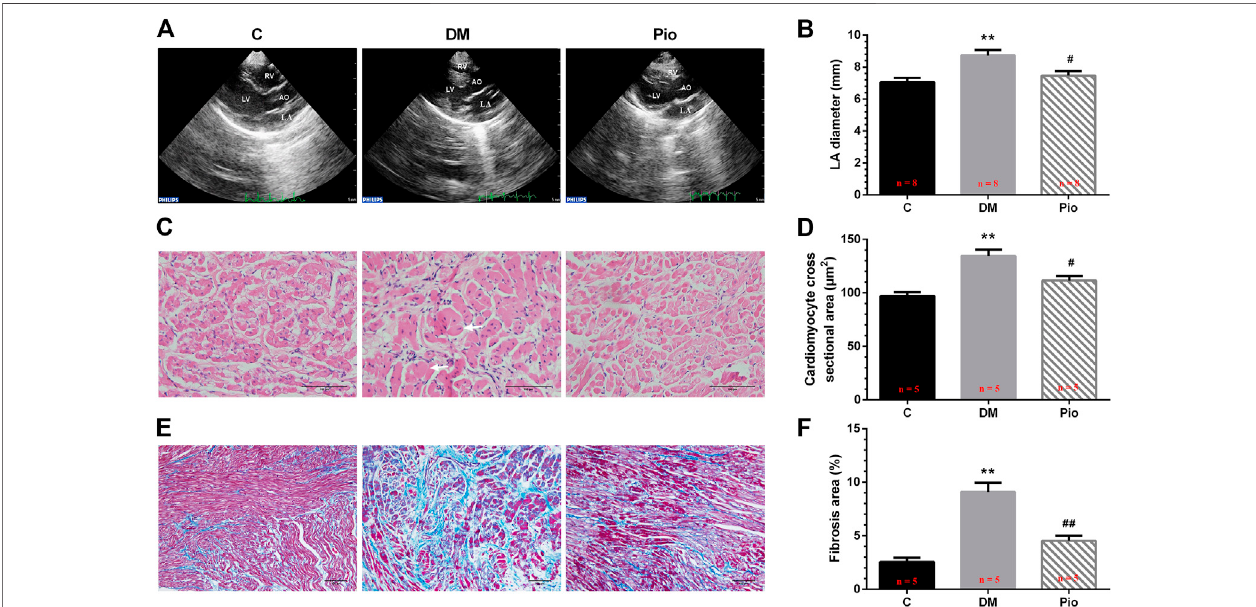
FIGURE 1 | Pioglitazone attenuated diabetes-induced atrial structural remodeling. Representative echocardiographic images (A) , left atrial diameter (B) , H&E staining (400 × magni fi cation) (C) , atrial cardiomyocyte diameter (D) , Masson ’ s trichrome staining (200 × magni fi cation) (E) , and interstitial fi brosis (F) from the control, diabetes mellitus (DM), or pioglitazone-treated DM (Pio) groups. LA, left atrium; LV, left ventricle; RV, right ventricle; and AO, aorta. Arrows indicate hypertrophic atrial myocytes in diabetic rabbits. Values are presented as mean ± SEM. **Compared with the C group, p < 0.01; # compared with the Diabetic group, p < 0.05; ## compared with the Diabetic group, p < 0.01. n (cid:2) 5 – 8 per group.